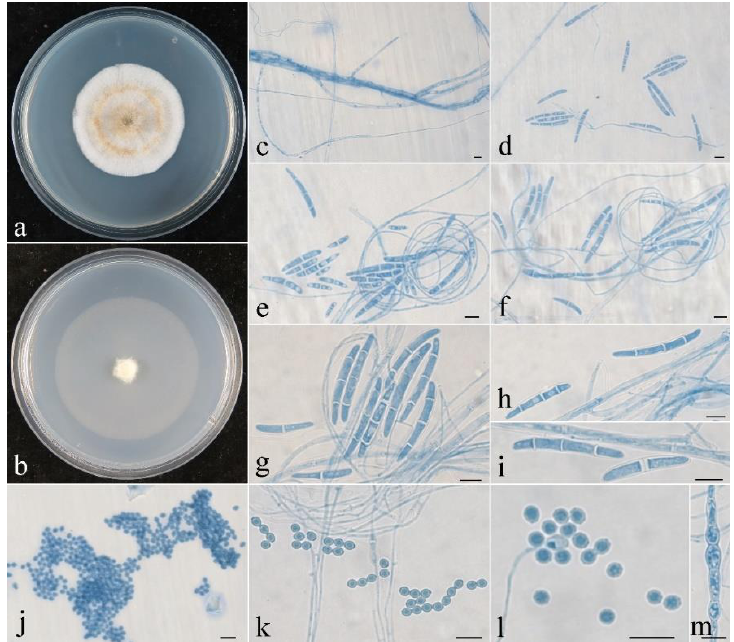
Figure 9. Colonial and microscopic morphology of Thelonectria globulosa (CGMCC 3.24132). ( a ) Colony after 2 week at 25 °C on PDA; ( b ) colony after 2 week at 25 °C on SNA; ( c ) conidiophores in